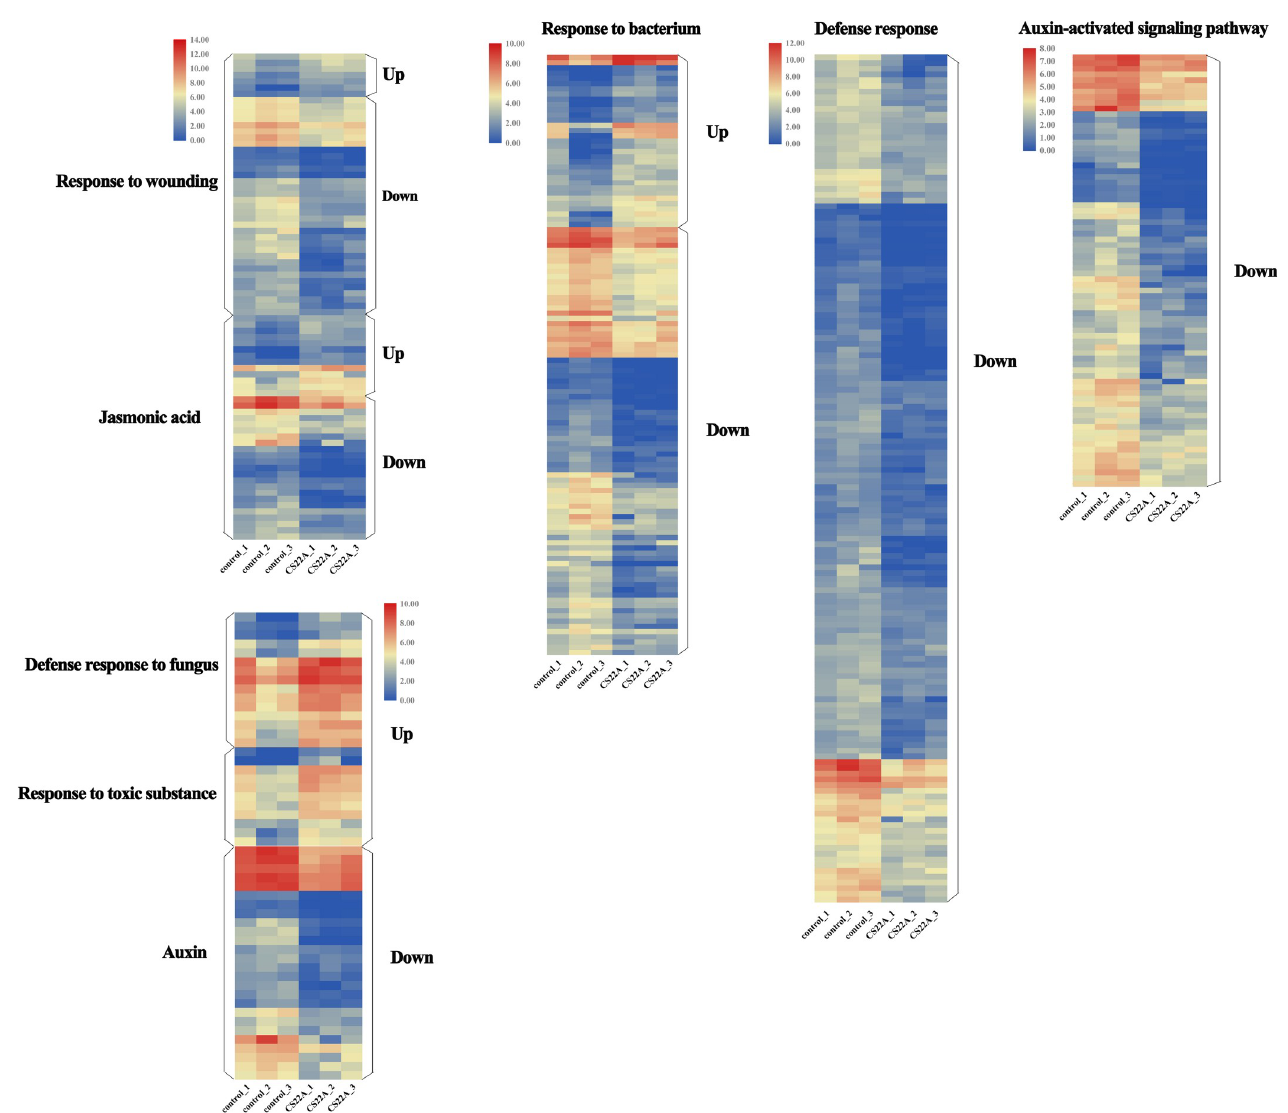
Fig 5. Heatmaps of significantly differentially expressed mRNAs classified by biological